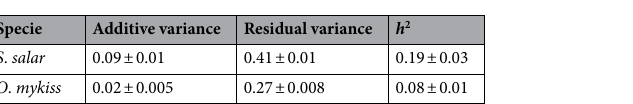
Figure 1. Histogram for log lice density (LogLD) for S. salar (green) and O. mykiss (orange).